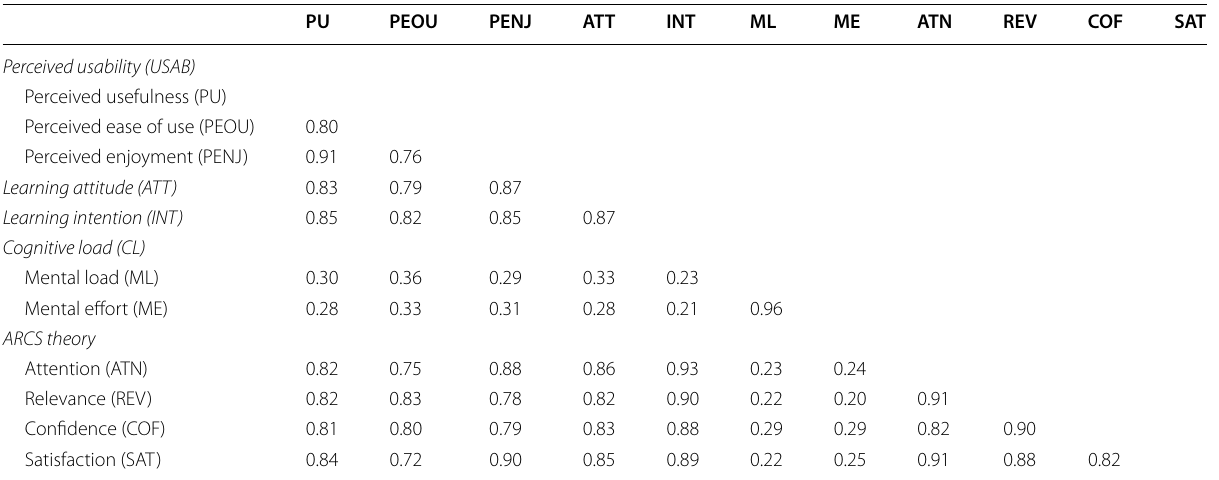
Table 4 Heterotrait–monotrait ratio